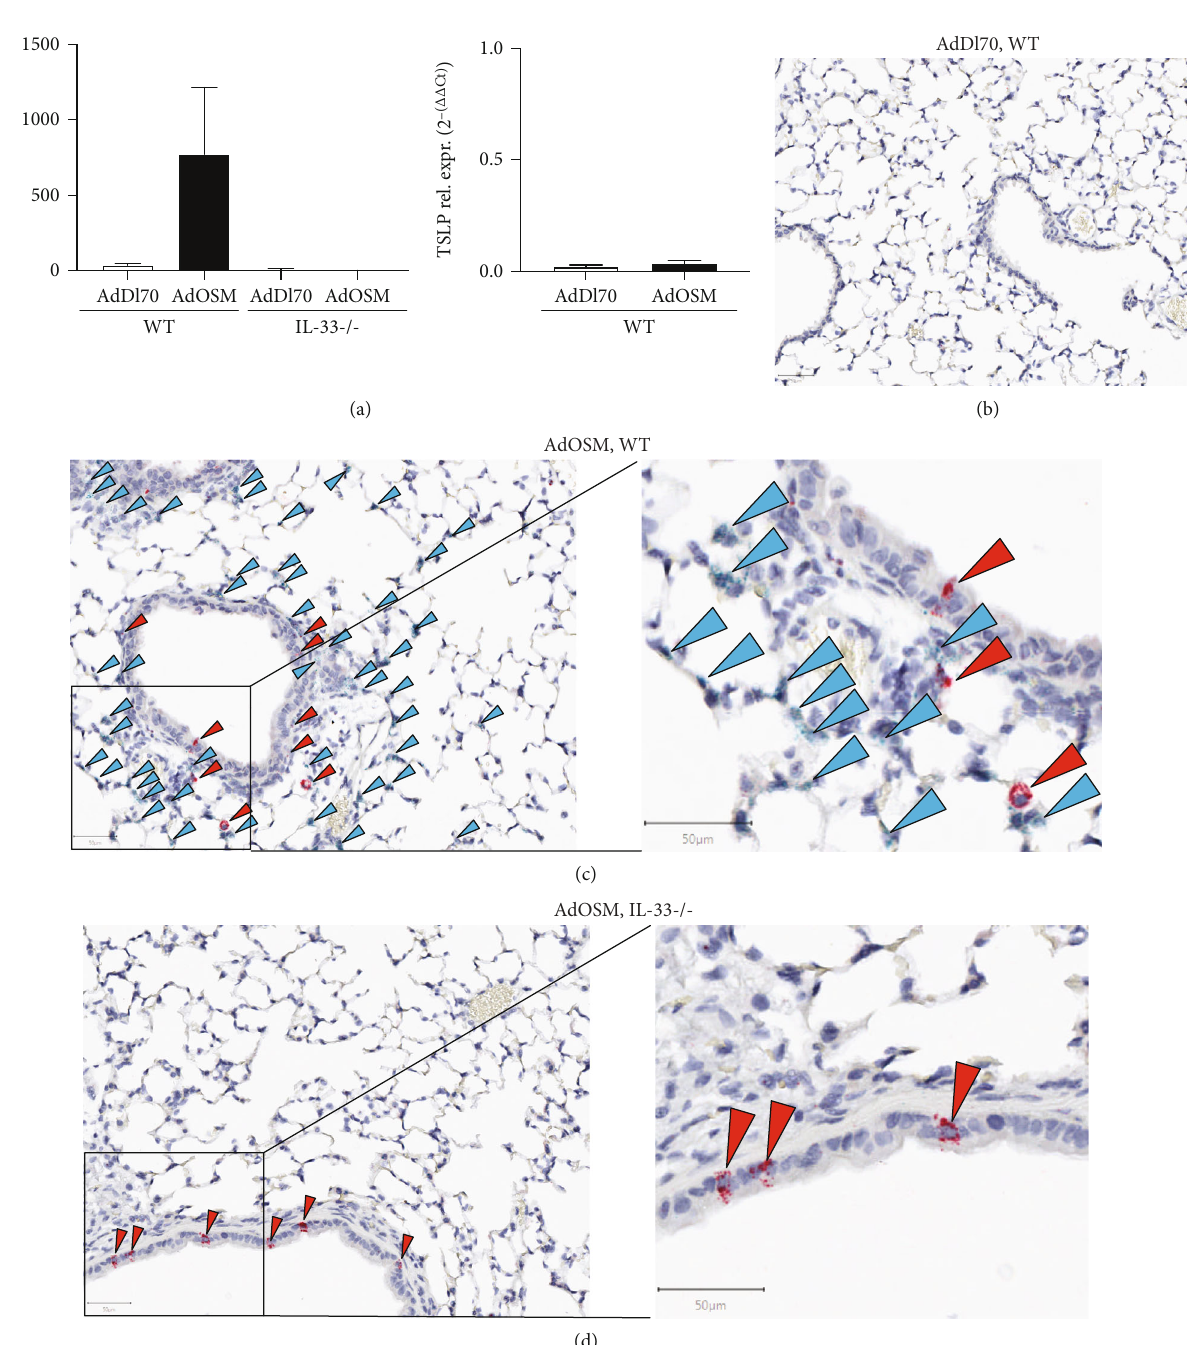
Figure 2: AdOSM-induced upregulation of mouse lung IL-33 mRNA and localization of IL-33 and OSM-mRNA expressing lung cells. C57Bl/6 wild-type (WT) or IL-33-/- mice were endotracheally administered AdDl70 (control) or AdOSM and analyzed after 7 days for IL-33 and TSLP mRNA expression from whole lung by qPCR (a). IL-33 and OSM mRNA expression was assessed within histological lung sections by chromatographic in situ hybridization (CISH) in AdDl70 (b), AdOSM in WT (c, right panel showing higher magni fi cation) or AdOSM in IL-33-/- mice (d, right panel showing higher magni fi cation). Red arrowheads: OSM+ mRNA signal; green arrowheads: IL-33+ mRNA